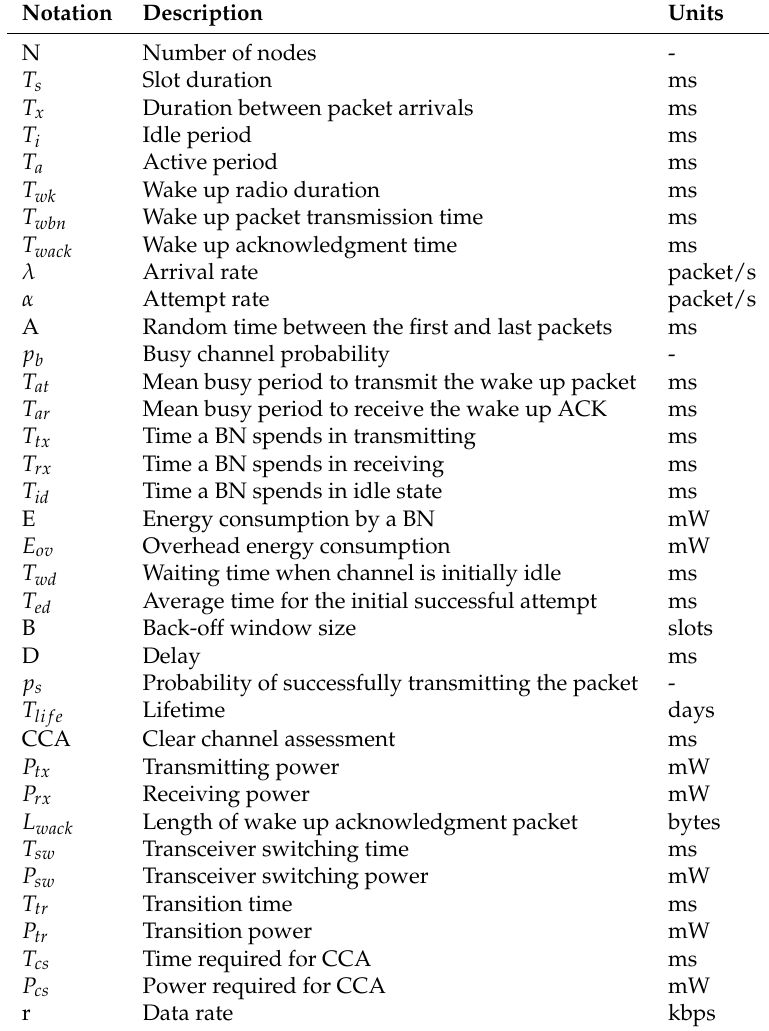
Table 3. Description of